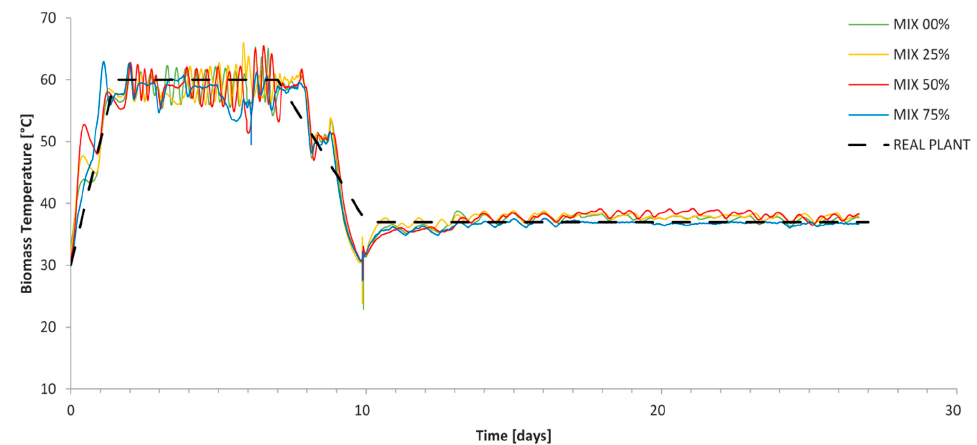
Figure 6. Temperature profiles during composting process.